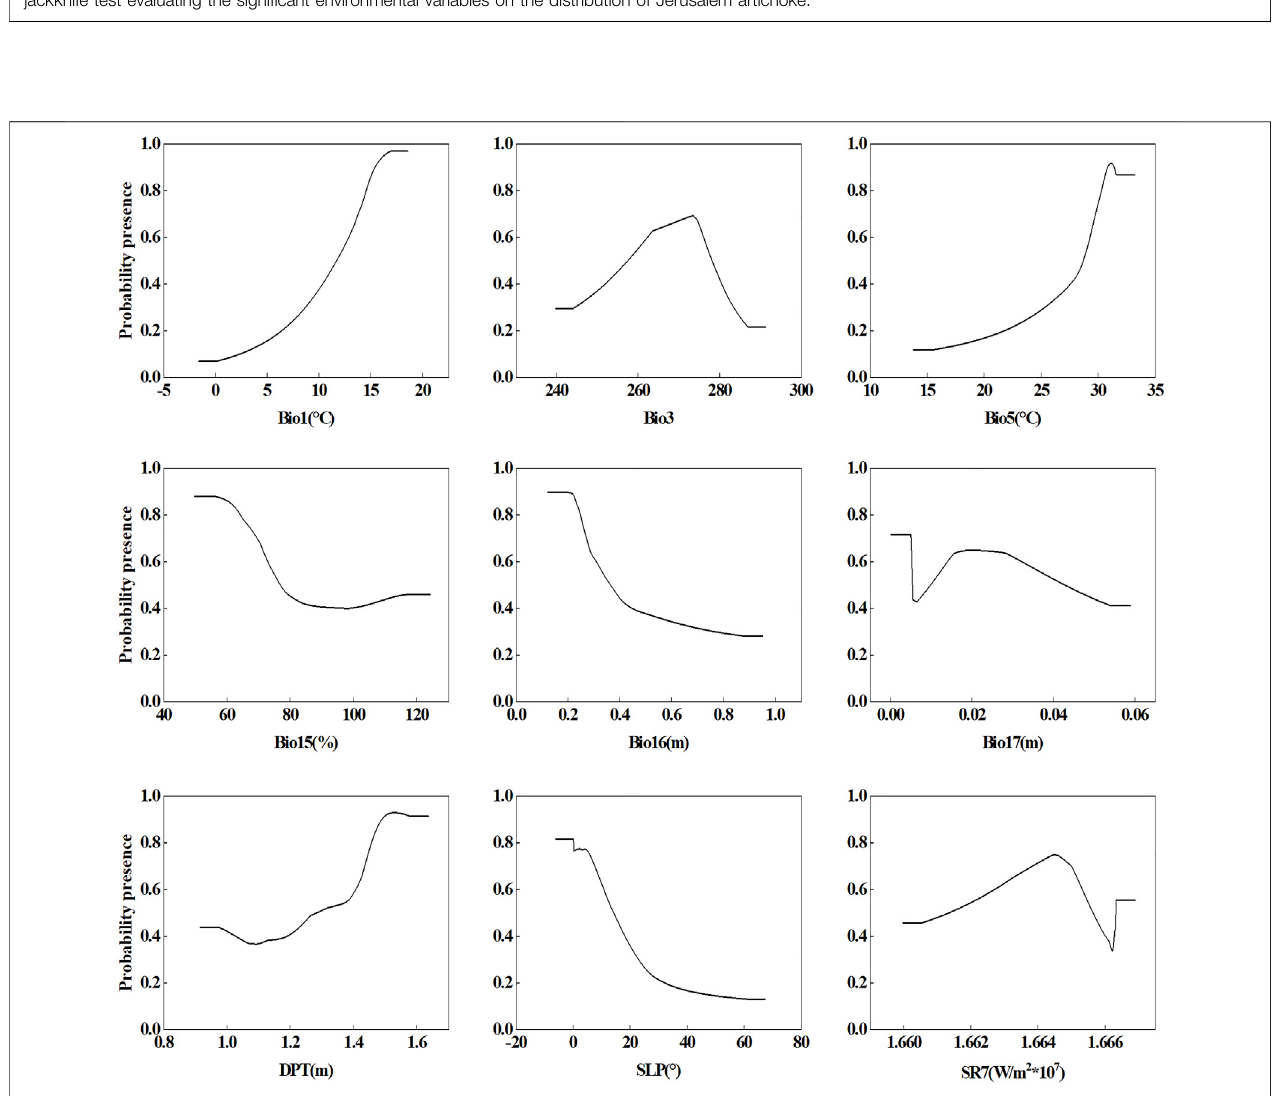
FIGURE 3 | The mean response curves of the 9 signi fi cant environment variables of the Maxent model calculated in 10 replicates.